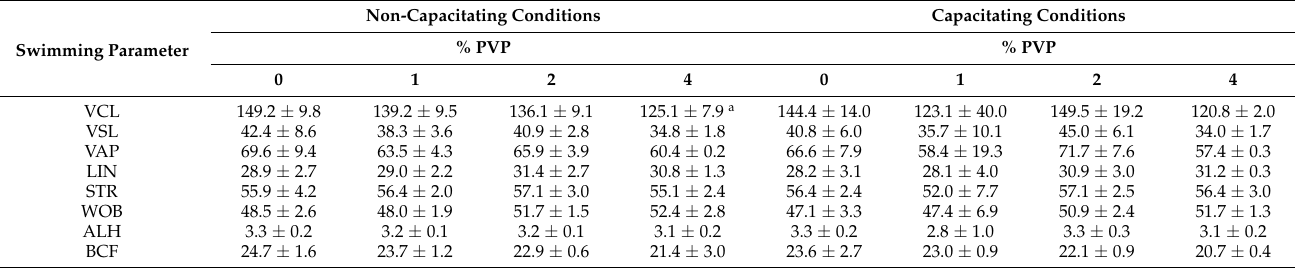
Table 1. Effect of various concentrations of PVP on the kinetics of spermatozoa from Mus musculus incubated under non-capacitating conditions (mT-H medium under air) or capacitating conditions (mT-BH medium under 5%CO 2 /air) for 30 min. VCL: curvilinear velocity; VSL: straight-line velocity; VAP: average path velocity; LIN: linearity; STR: straightness; WOB: wobble coefficient; ALH: ampli- tude of lateral head; BCF: beat cross frequency. Means ± SE (N = 4) are reported. Letters indicate different levels of significance between different PVP concentrations and control (0% PVP) in Tukey’s post-hoc test ( a : p <